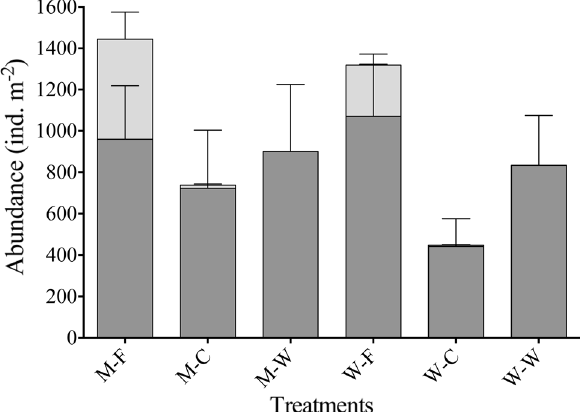
Fig. 5. Mean abundance (±SE, n = 8) of macrofauna present in sediments (dark grey) and on anti-predator nets (pale grey) from plots subjected to 1 of 6 treatments. Abundance is the number of individuals per square metre to have the unit consistent for sediment and nets. Treatments are combi - nations of presence (M) or absence (W) of Manila clams Venerupis philippinarum and anti-predator net status (F: fouled; C: cleaned; W: